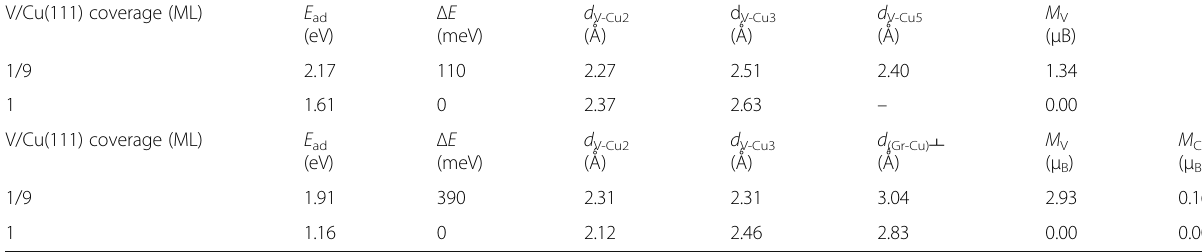
Table 1 Adsorption energies at subT sites E ad , spin polarization energies (per V atom) of V atoms Δ E, the bond lengths between V atom and its adjacent Cu and C atoms d V-Cu and d V-C , the vertical distance between the lower C layer and the uppermost Cu layer M M d (Gr-Cu) ⊥ , and atomic magnetic moments of V and C atoms V and C . For the subscript of Cu and C atoms, please refer to Fig. 2 V/Cu(111) coverage (ML) E ad (eV)